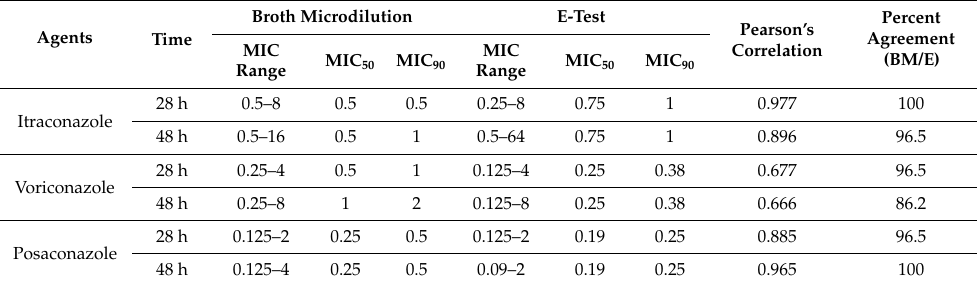
Table 1. Comparison of EUCAST broth microdilution and E-test